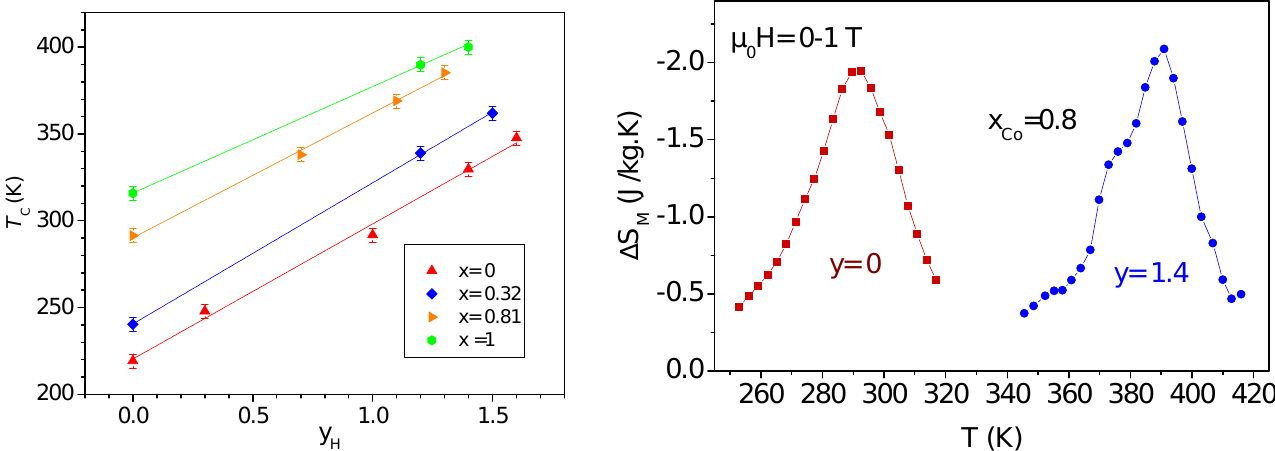
Figure 14. ( Left ) Evolution of T C versus H concentration for different Co rates, ( Right ) Comparison of ∆ S M for LaFe 9.7 Co 0.8 Si 1.5 H y ( y = 0 and 1.4) and a field variation